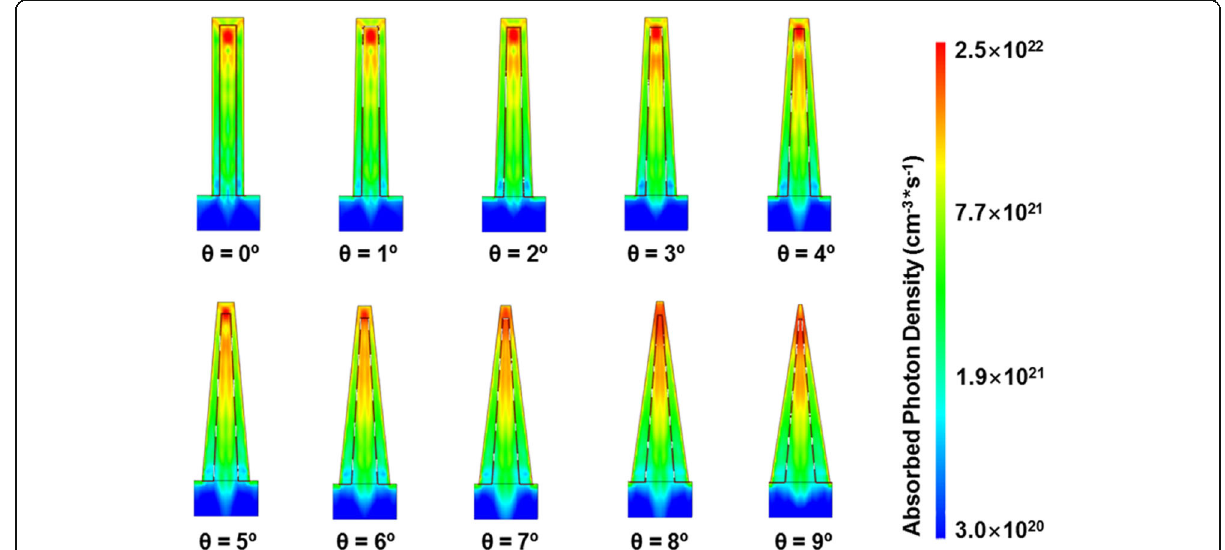
Fig. 8 The optical generation profiles of the radial pin nanocone arrays with different slope